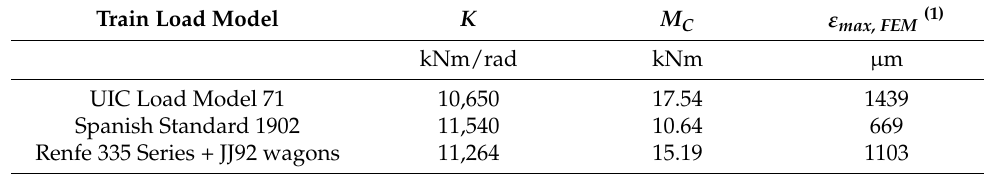
Figure 16. Maximum bending moment M C at stringer-floor beam connections corresponding with cross-section at interme- diate bridge piers (global FE model). ( a ) Location of connections. ( b ) Bending moment at connections along the bridge. Table 4. Results from global and local numerical models (non-strengthened